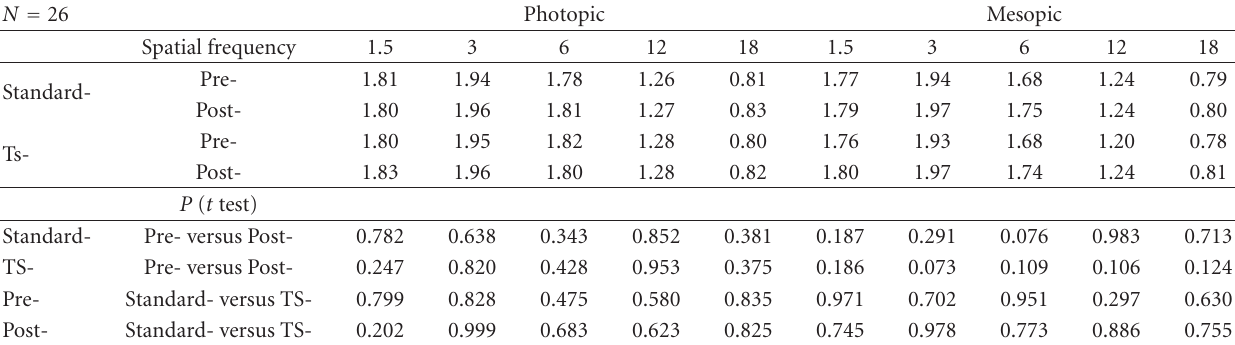
Table 2: Pre- and postoperative contrast sensitivity in Group 1 (sphere (cid:2) − 3D) underwent tissue-saving LASIK or standard LASIK. N =